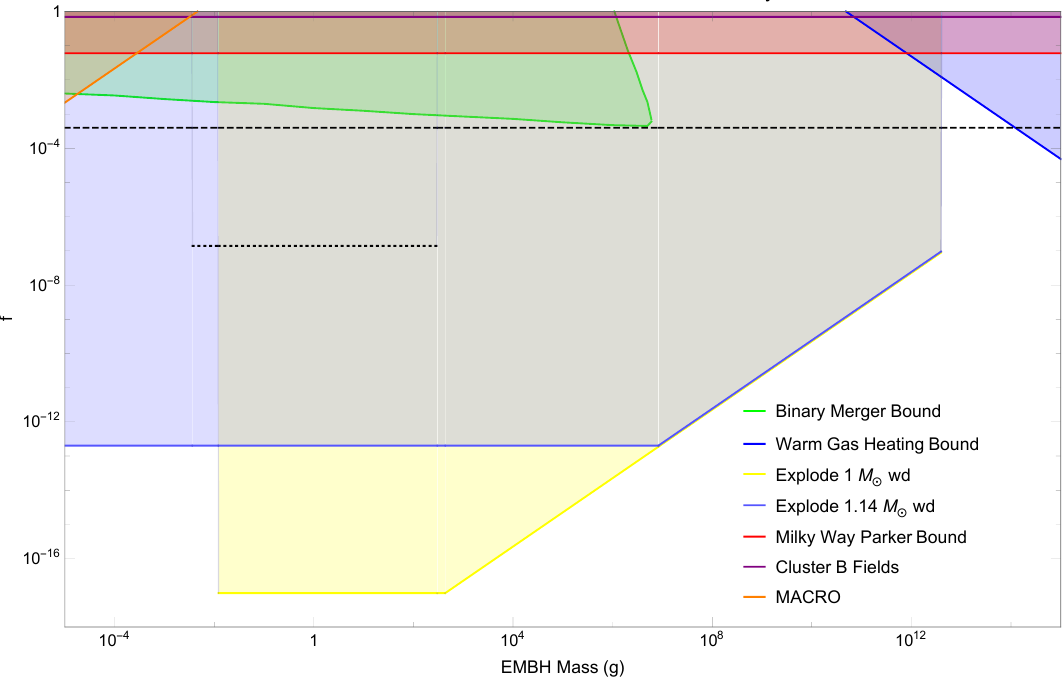
Figure 1 . These are the bounds on the EMBH abundance, f , if nucleon catalysis effects, described in section 4, are neglected. The green region is ruled out by gamma-rays emitted from binary mergers, (see section 3.3). The yellow and light blue regions are respectively ruled out by the existence of 1 Gyr old non-magnetic 1 M (cid:12) WDs and by WD J0551+4135 which EMBHs can destroy (see section 3.2). The dark blue region is ruled out by EMBHs overheating warm ionized gas clouds in the Milky Way (see 3.1). The red and purple regions are ruled out by EMBH interaction with large scale magnetic fields (see section 3.4). The orange region is ruled out by monopole searches by MACRO, which is described in section 3.5. For comparison, we show EMBH bounds set by Bai et al. in ref. [15] in black. The dashed bound comes from the Parker effect in the Andromeda Galaxy (see section 3.4), and the dotted one comes from EMBH annihilation in the Sun producing excess neutrinos (see section 4.4). We cut off the latter bound at M > 300 g because convection in the Sun can suppress the annihilation rate for these